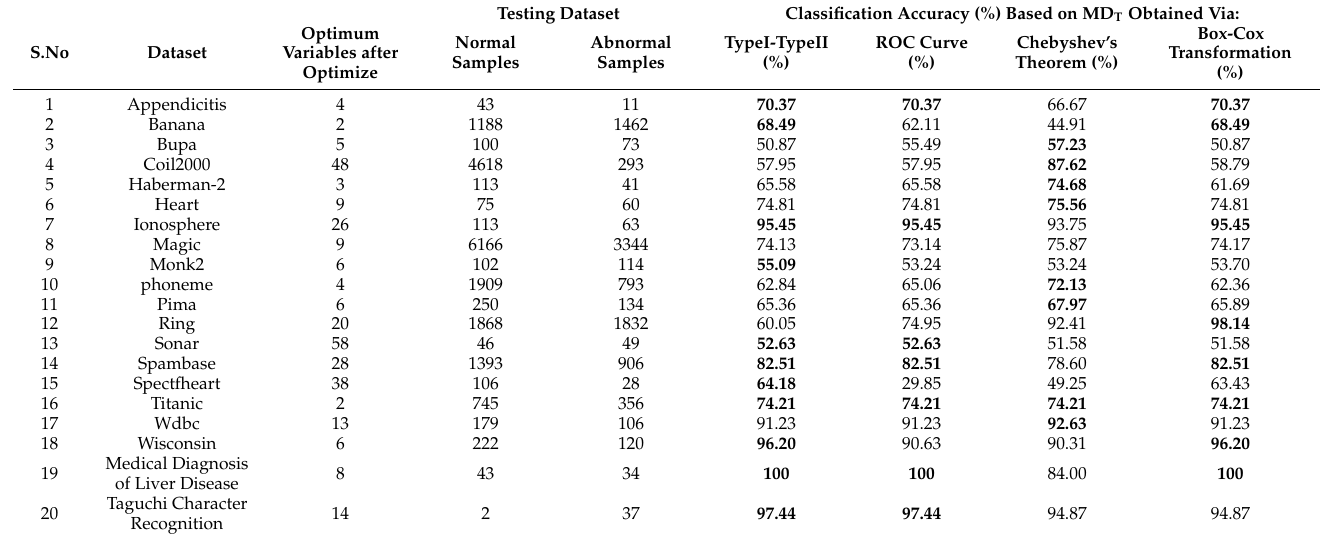
Table 9. Classification accuracy based on MD T suggested by each threshold method. Testing Dataset